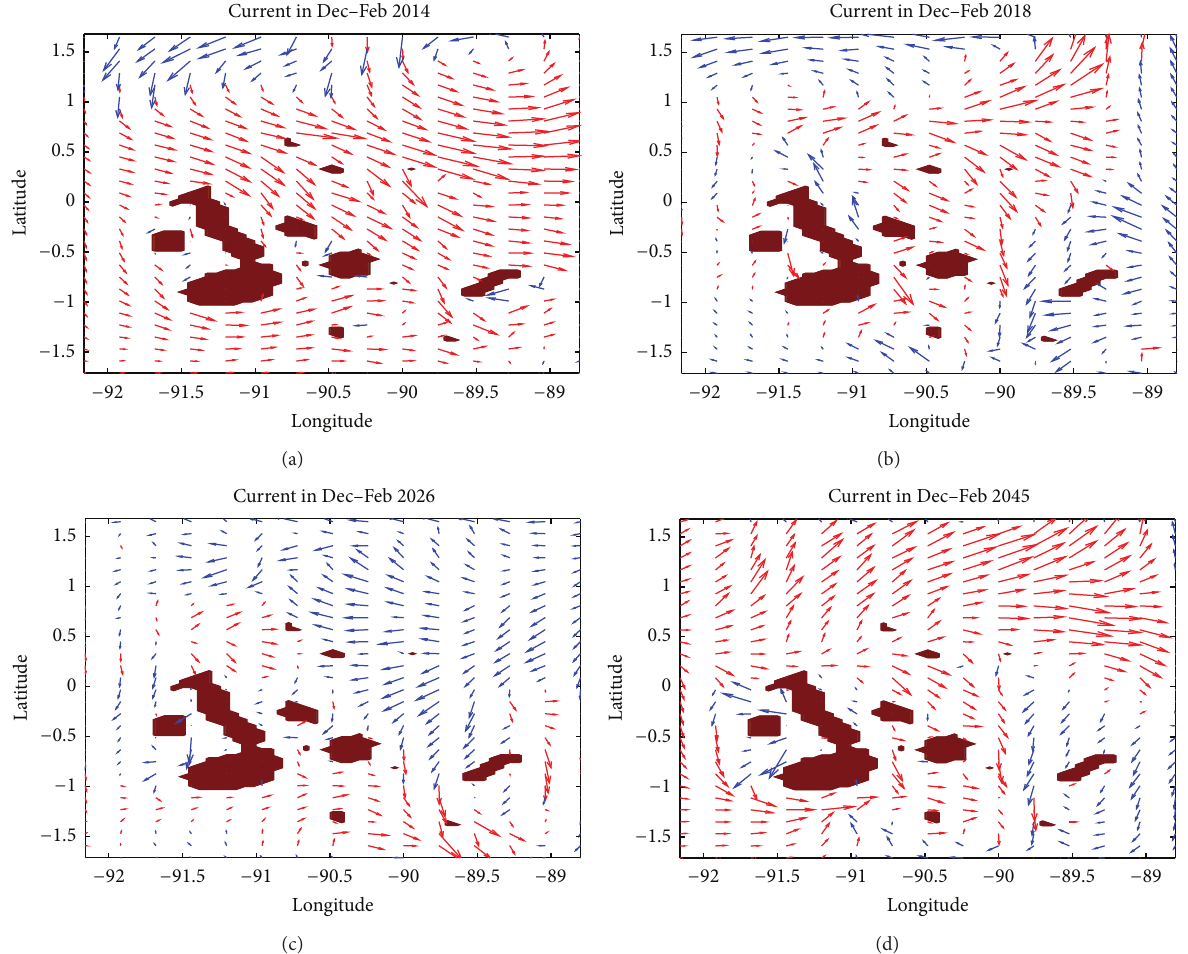
Figure 14: The current at 40 m around the GMR during the La Ni˜na cases: (a) in Dec–Feb in 2013-2014, (b) in Dec–Feb in 2017-2018, (c) in Dec–Feb in 2027-2028, and (d) in Dec–Feb in 2044-2045. shown by Fiedler and Talley [38], with a marginal decrease (increase) during El Ni˜no (La Ni˜na) as upwelling within the equatorial cold tongue is slightly suppressed